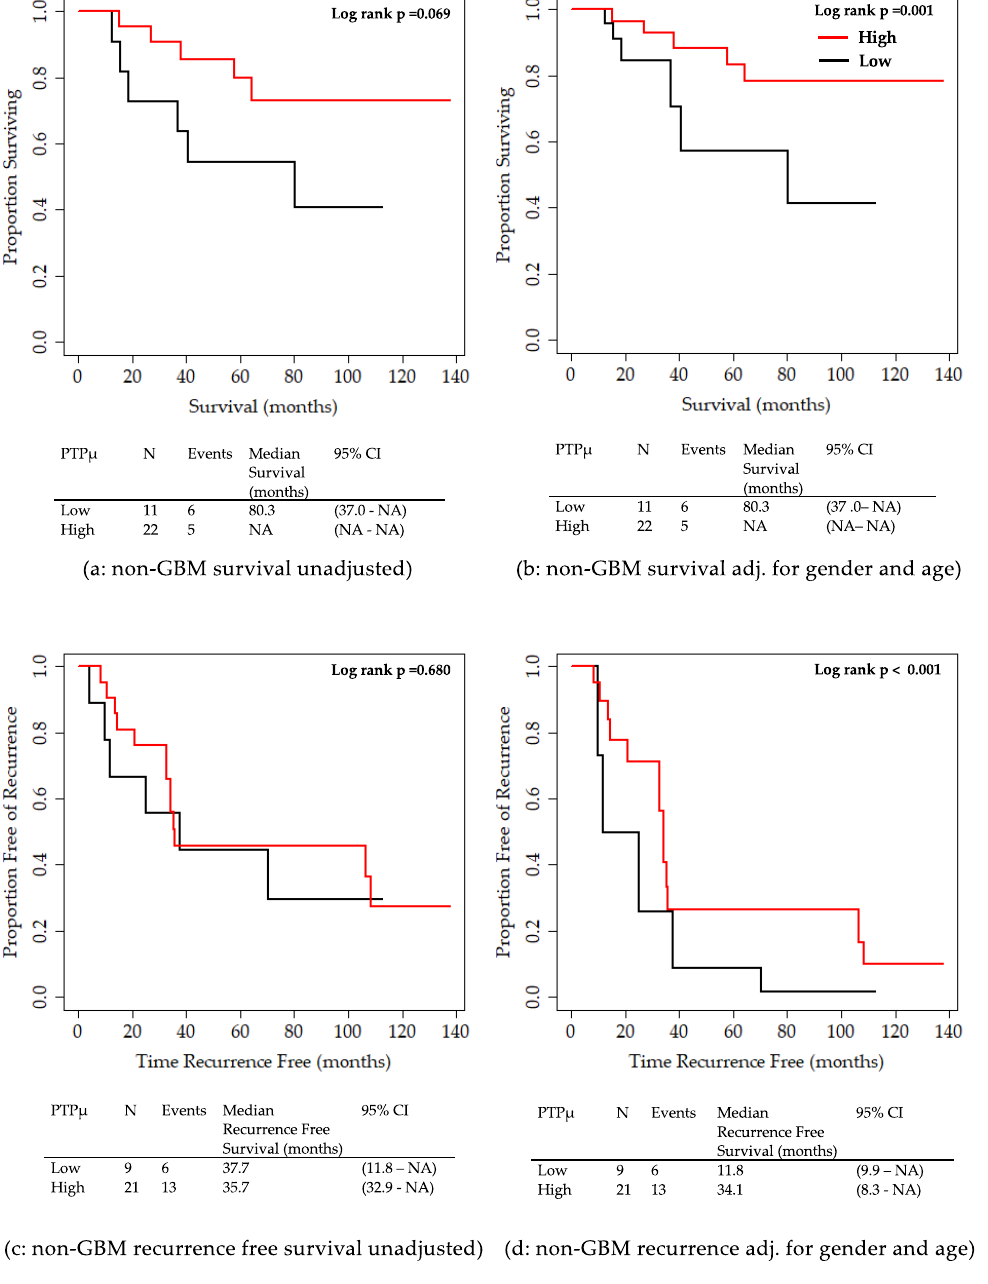
Figure 6. Kaplan Meier survival plots for overall survival and recurrence-free survival by PTPµ high versus PTPµ low staining for patients with lower grade gliomas. ( a ) Unadjusted overall survival for lower grade (non-GBM) patients. ( b ) Overall survival adjusted for sex, age group, and IDH1 mutation for non-GBM patients. ( c ) Unadjusted recurrence-free survival for non-GBM patients. ( d ) Overall recurrence-free survival adjusted for sex, age group, and IDH1 mutation for non-GBM patients. Median overall survival or recurrence-free survival with 95% CIs are shown below each plot. Based on the log-rank test, the adjusted recurrence-free survival curves were significantly different between PTPµ high and low non-GBM patients.